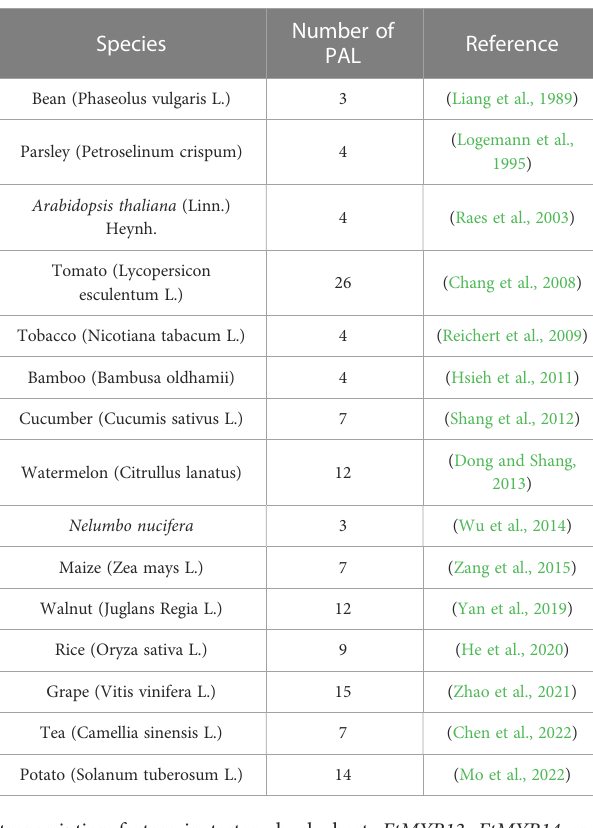
TABLE 1 PAL gene identi fi ed in multiple